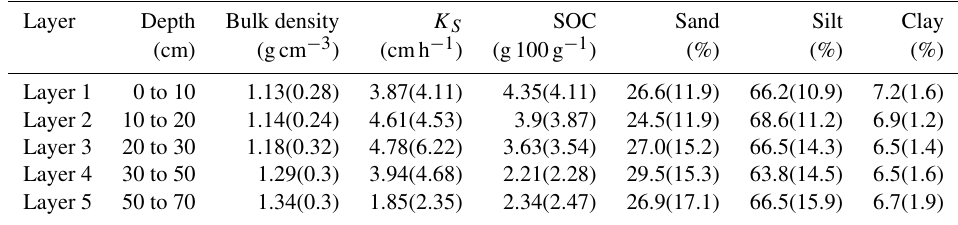
Table 1. Statistics of the physical characteristics of the soil at the 35 soil moisture stations: mean (standard deviation). Layer Depth Bulk density K S SOC Sand Silt Clay (cm) (gcm − 3 ) (cmh − 1 ) (g100g − 1 ) (%) (%) (%) Layer 1 0 to